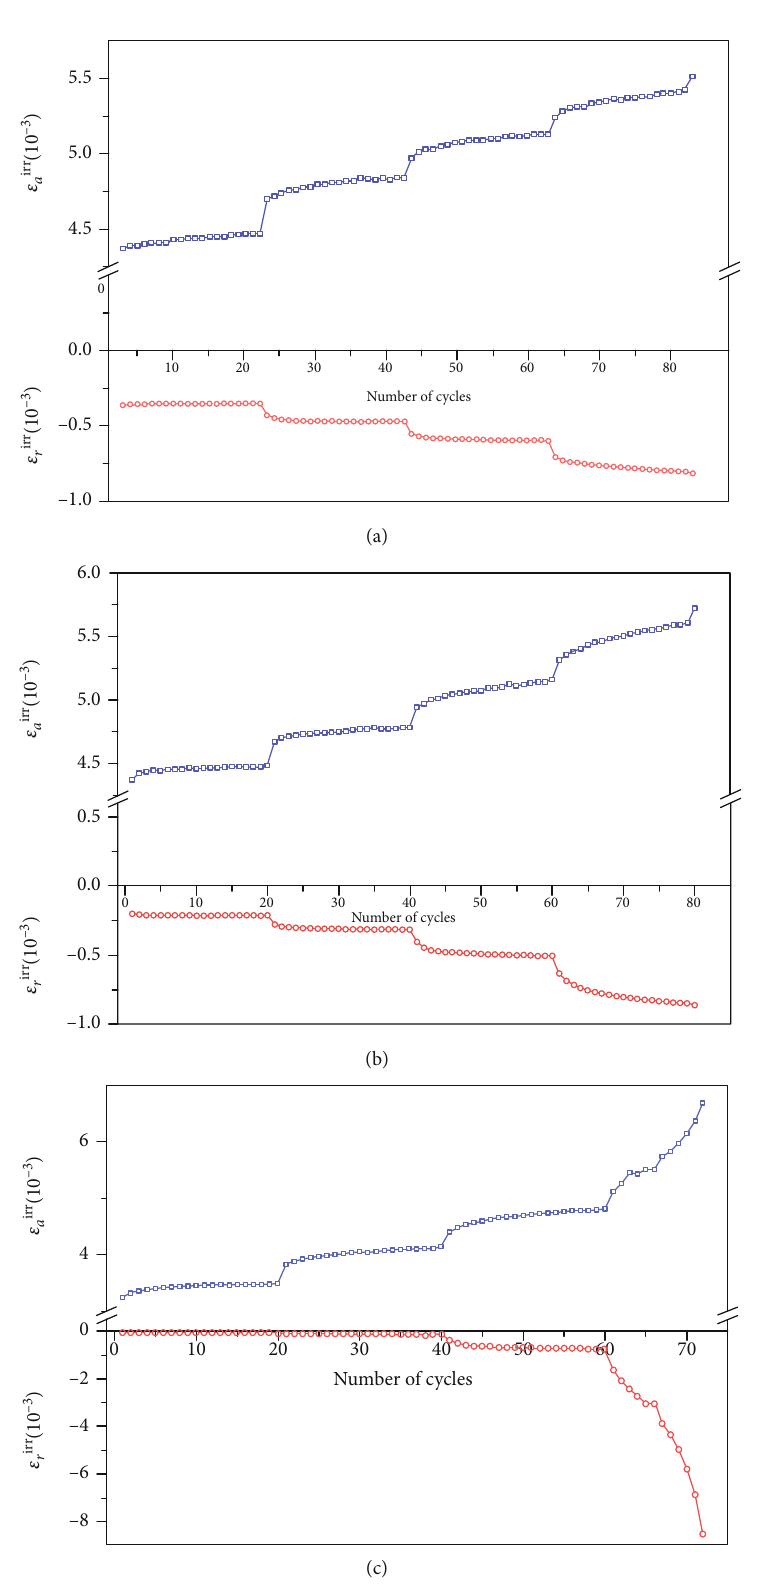
Figure 7: Evolution of irreversible strain with the number of cycles under di ff erent loading frequencies: (a) 0.1Hz; (b) 0.2Hz; (c)